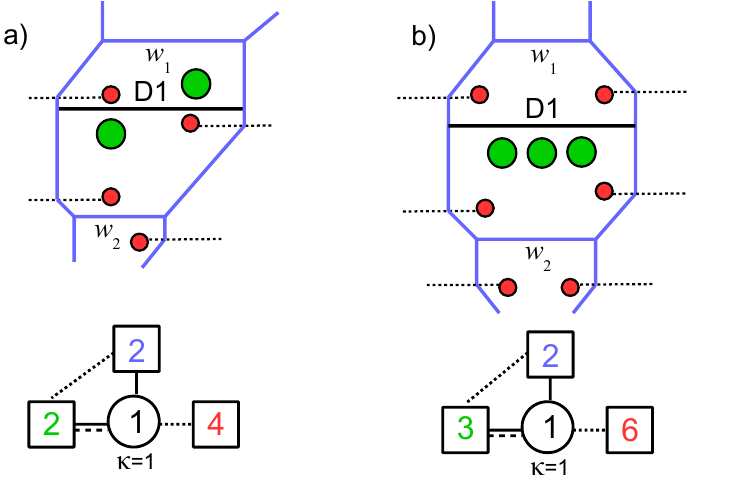
Figure 14 . Partial completion of the brane setup for the L 1 ; 1 bubbling in the (a) SU(2) and (b) SU(3) theory. The resulting SQMs have Chern-Simons level (cid:20) = 1.